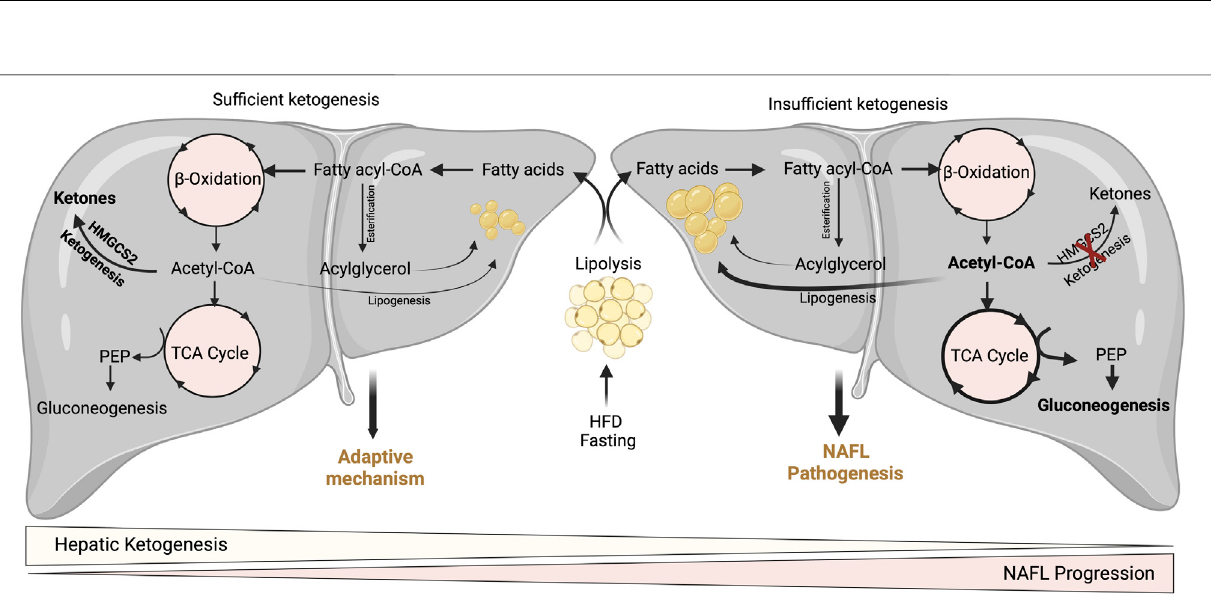
Frontiers in Physiology |